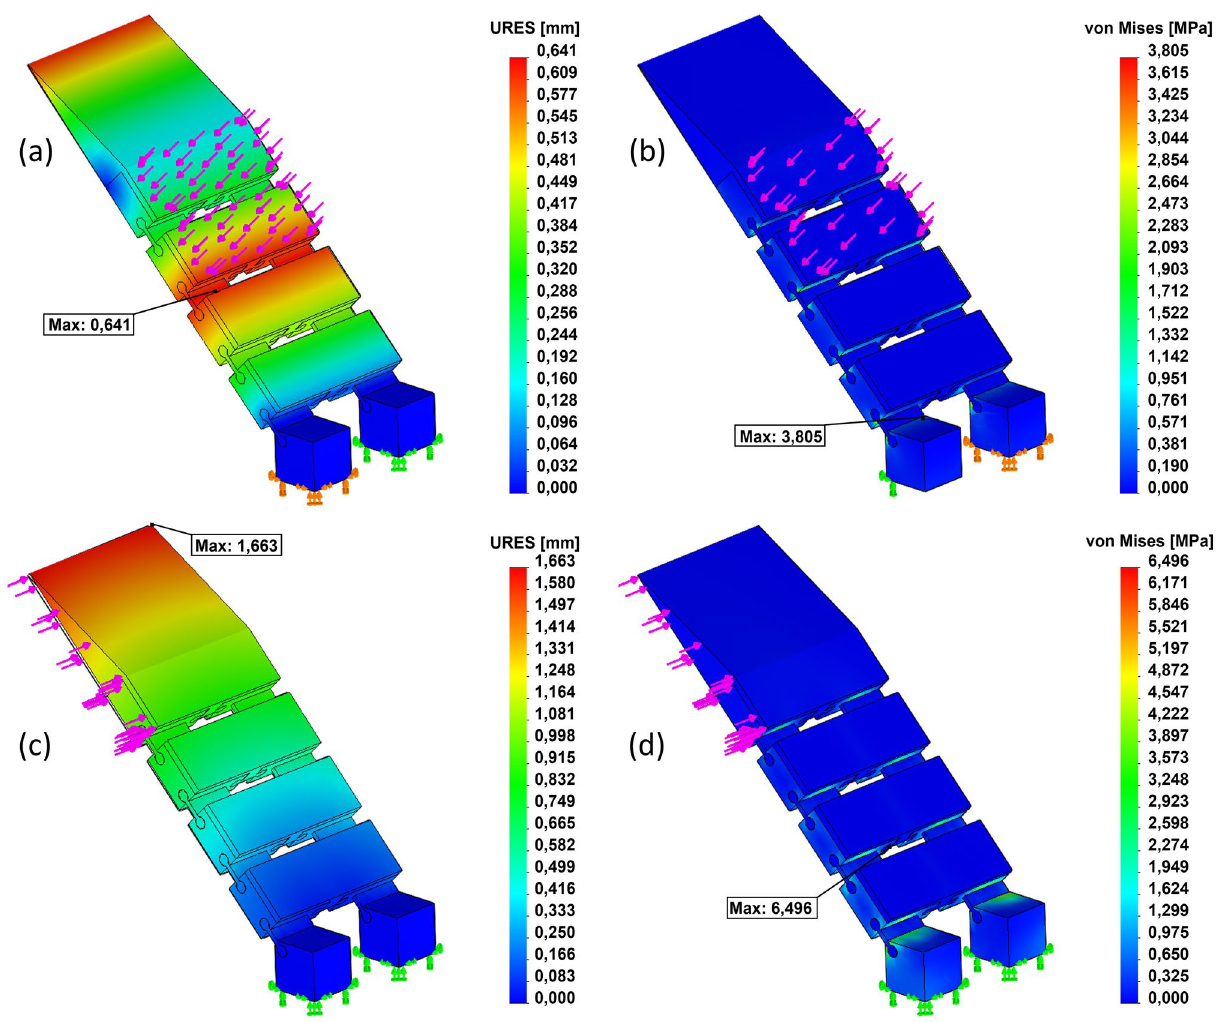
Fig. 11 TPU-ASA a displacement first configuration; b von Mises stress first configuration; c displacement second configuration; d von Mises stress second